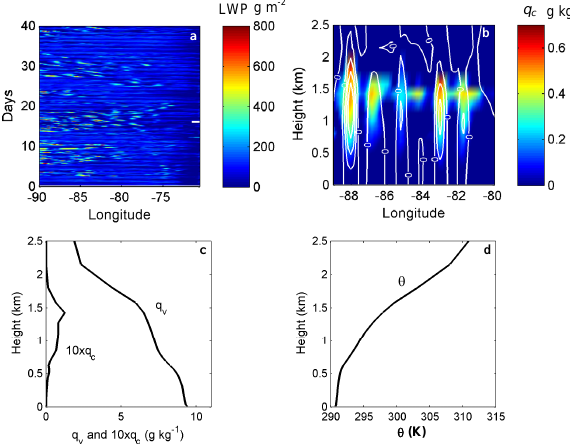
Fig.10. Examples of grid-scale convection in the COAMPS simulation. (a) Longitude- time cross-section of the COAMPS LWP along 20º S, (b) longitude-height cross-section Fig. 10. Examples of grid-scale convection in the COAMPS sim- of the instantaneous q c (color shading) and w (contours starting at 0 cm s -1 with an in- terval of 5 cm s -1 ) along 20º S at 0300Z 5 November 2008 [denoted by the white bar on ulation. (a) Longitude-time cross-section of the COAMPS LWP the right axis in (a)], (c) mean profiles of q v and q c averaged between 89º W and 80º W, along 20 ◦ S, (b) longitude-height cross-section of the instantaneous and (d) mean profile of θ . q c (color shading) and w (contours starting at 0cms − 1 with an in- terval of 5cms − 1 ) along 20 ◦ S at 03:00 UTC 5 November 2008 [denoted by the white bar on the right axis in a ], (c) mean profiles of q v and q c averaged between 89 ◦ W and 80 ◦ W, and (d) mean profile of θ